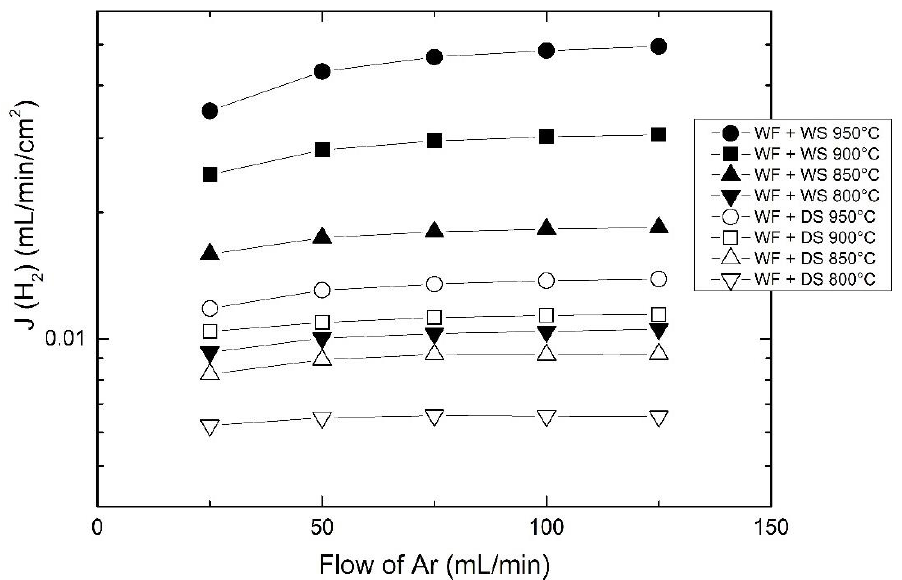
Figure 6. The apparent hydrogen flux as a function of sweep flow in the inner tube. The feed is wet 48.75% H 2 with a constant flow of 50 mL / min. The temperature ranges from 800 to 950 ◦ C.